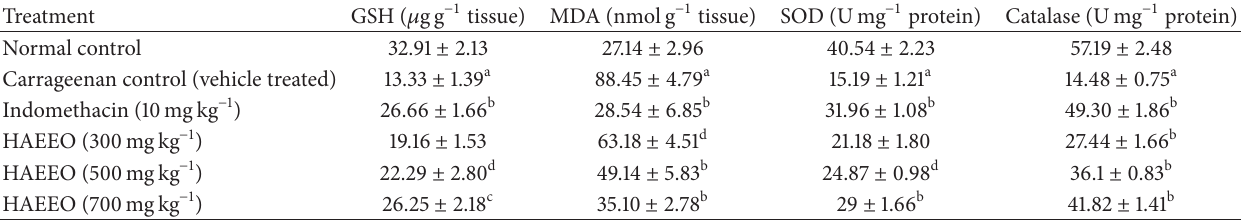
Table 1: Effect of HAEEO on oxidative stress parameters in carrageenan-induced paw edema in rats. Treatment